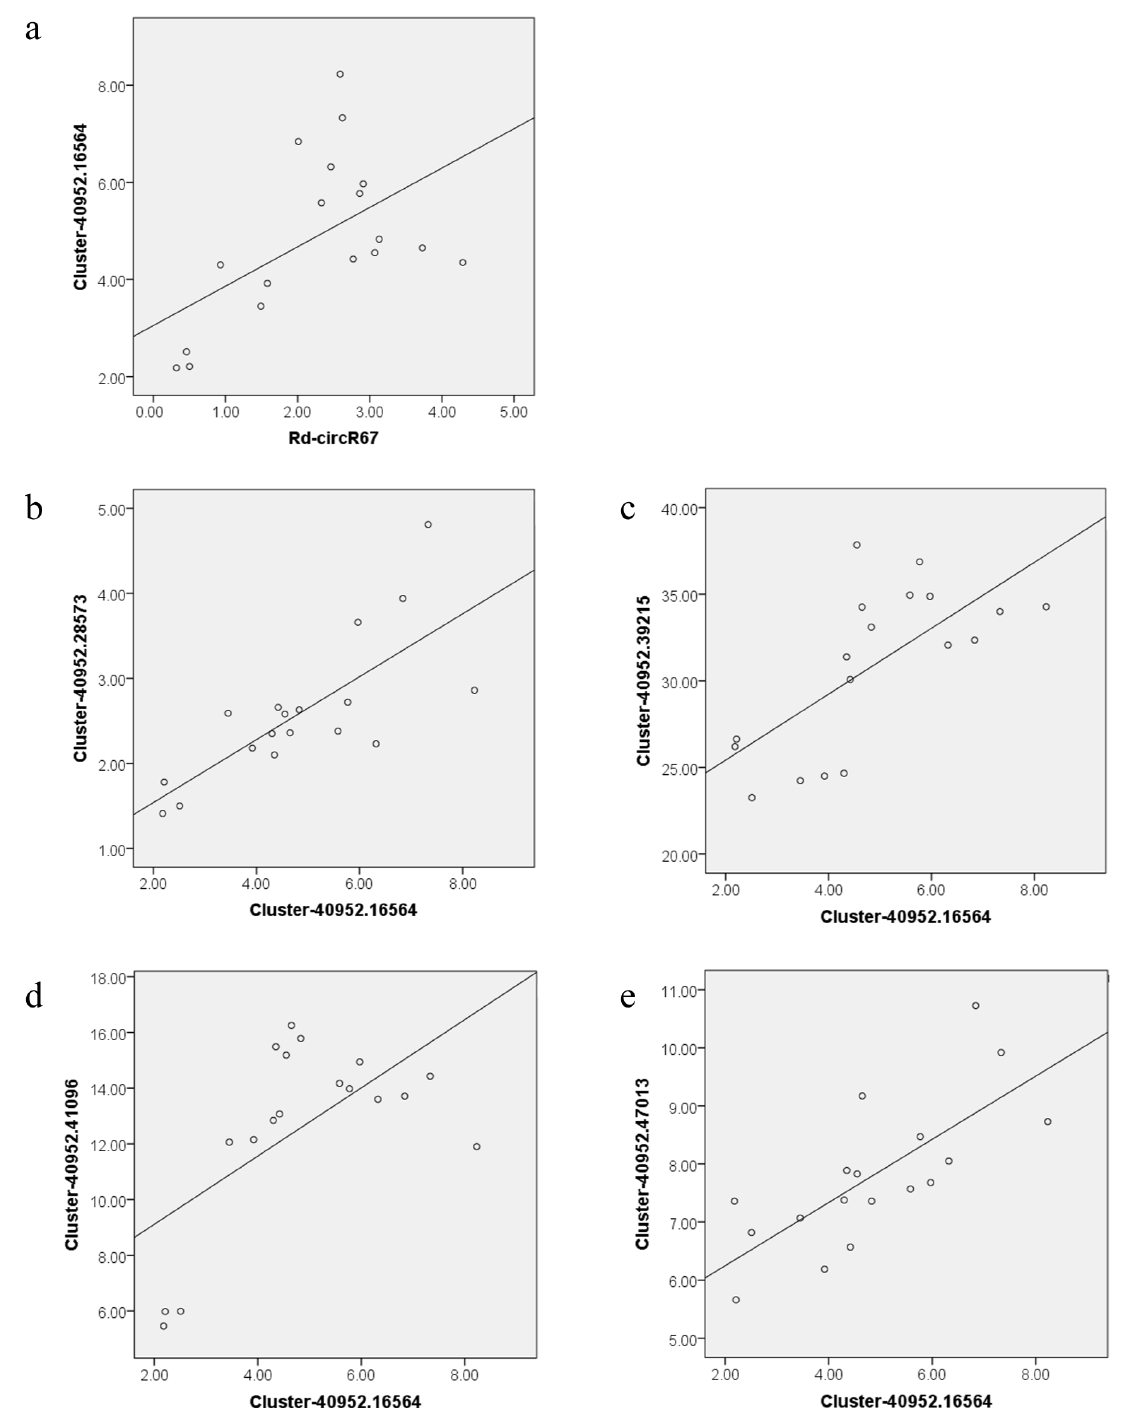
Figure 8. The Pearson correlation coefficient between the circRNAs and predicted target mRNAs: ( a ) the Pearson correlation coefficient between Rd-circR67 and CUL1 ; and ( b – e ) the Pearson correlation coefficient between CUL1 and COI1 .